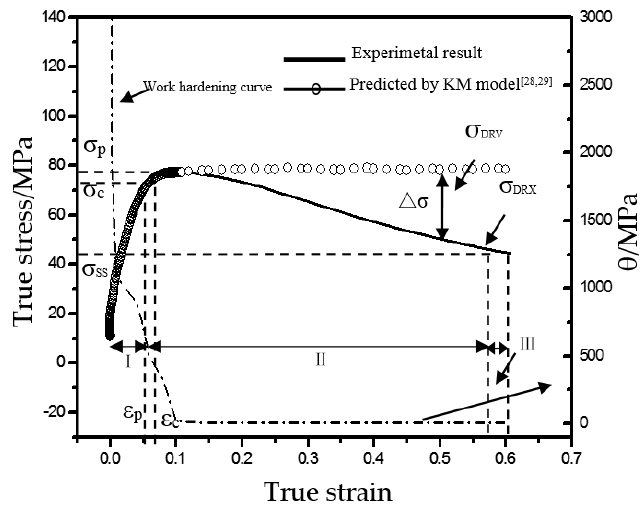
Figure 4. Flow stress curve and working hardening rate curve of Ti–6Al–4V.